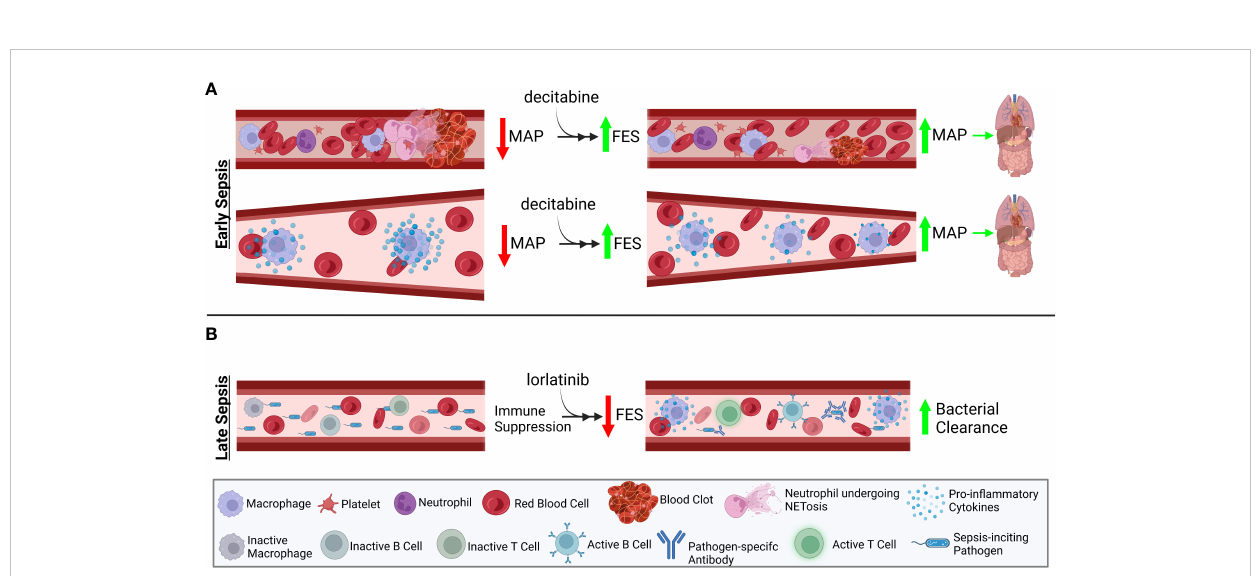
FIGURE 2 Therapeutic ef fi cacy of FES expression level changes is stage-dependent. Sepsis can be separated into two stages: early stage, characterized by overactive immune responses leading to decreased end organ perfusion; and late stage, characterized by immune suppression, preventing the ef fi cient clearance of the sepsis-inciting event. (A) Due to the over-stimulation of the immune system in early sepsis, treatment with decitabine, known to induce increased FES expression, will prevent overactivation of the immune system. (B) In contrast, overcoming the characteristic late- stage immunosuppression by treatment with lorlatinib, an inhibitor of FES activity, will promote greater pro-in fl ammatory cytokine production from immune cells. This increase in immune activation will aid in resolving the inciting event of sepsis. Created with